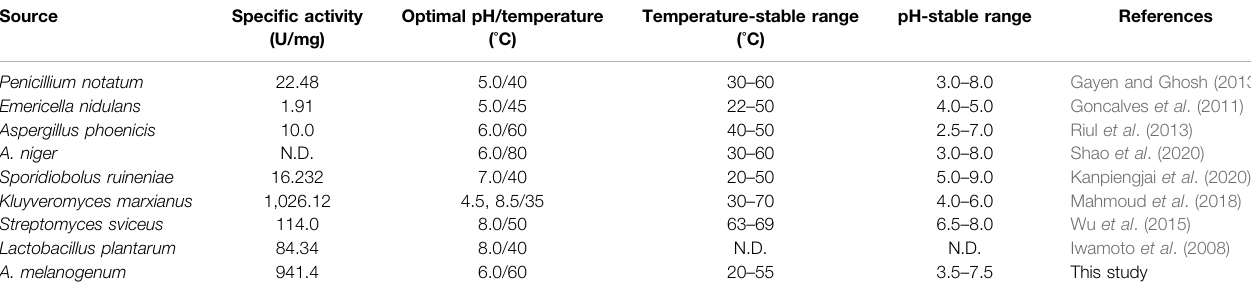
TABLE 3 | Biochemical properties of TanA and other reported